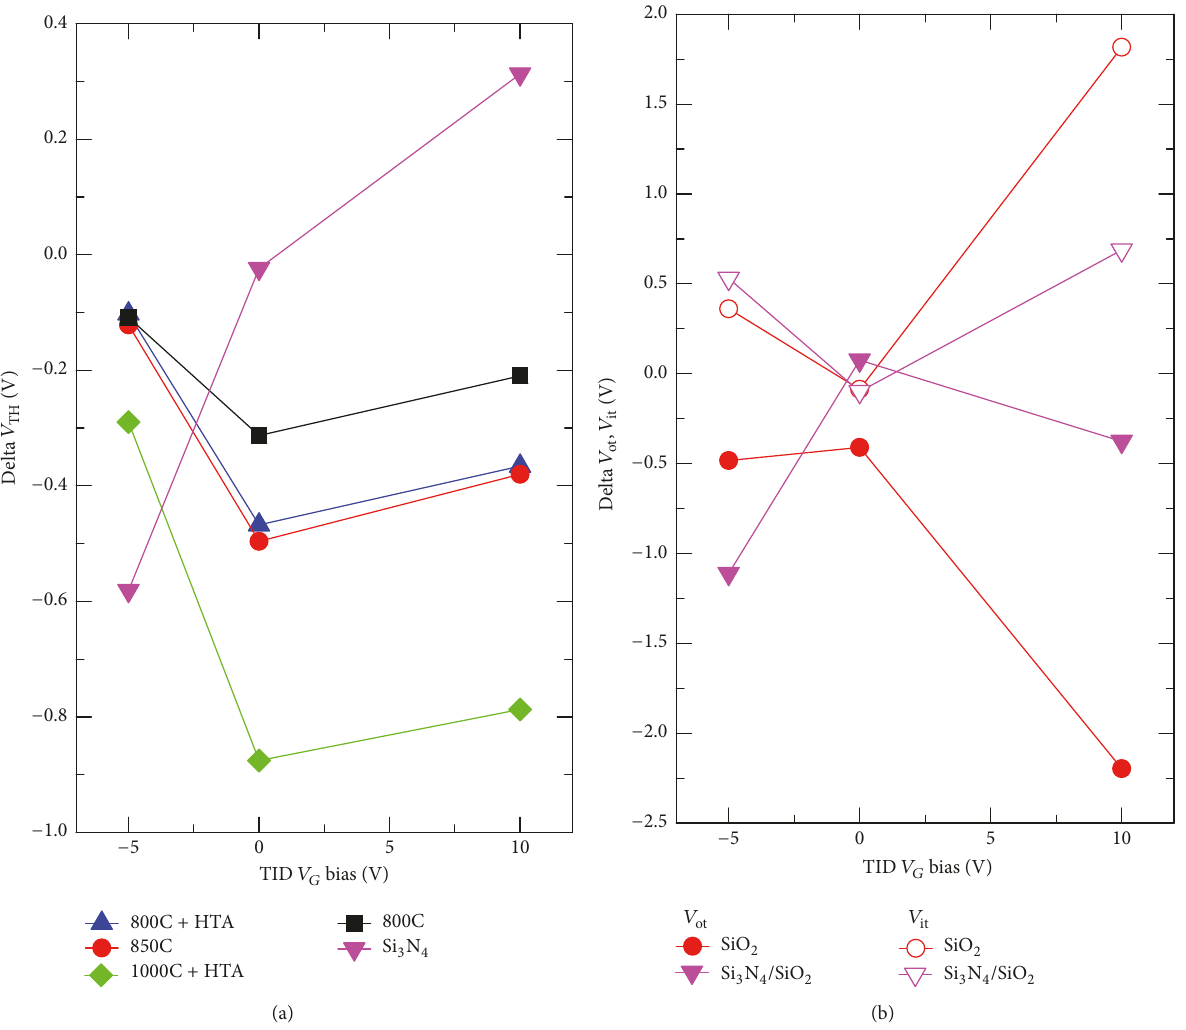
and Δ𝑉 characteristics of Si ot it